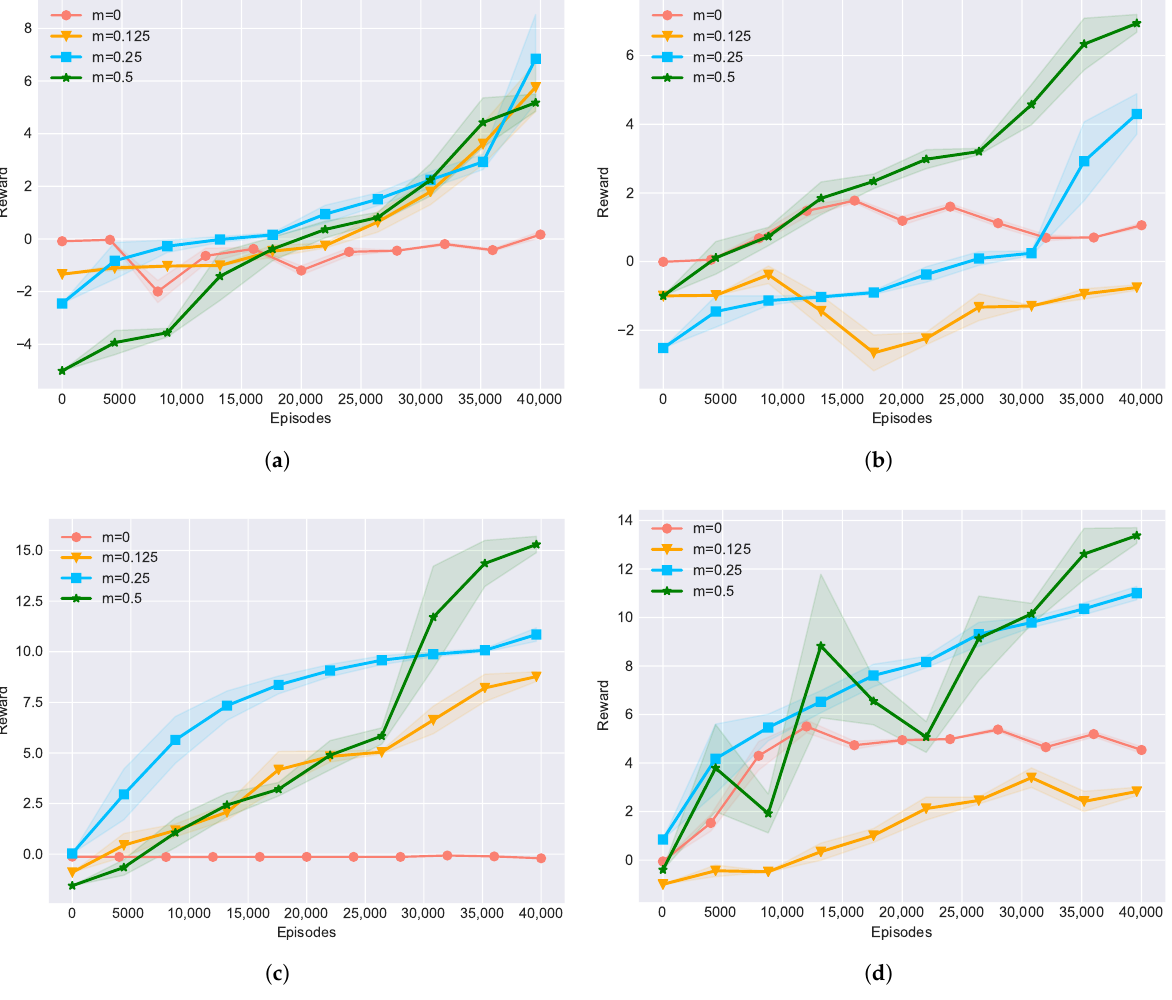
Figure 7. Ablation experiments on different RL population sizes, m , in training against the four baseline opponents: ( a ) TA, ( b ) TP, ( c ) LA, ( d )